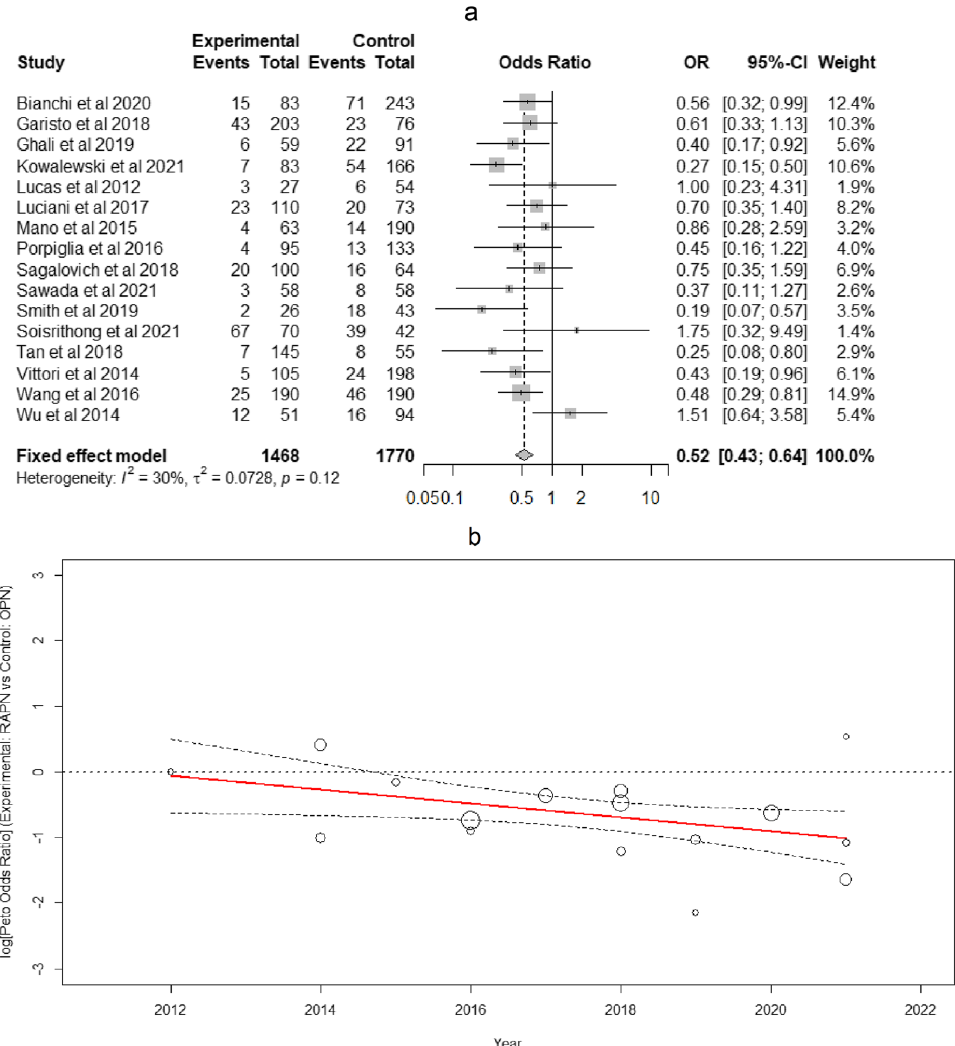
Fig. 3 a : Pooled analysis forest plot under the fixed effects model, showing a statistically significant reduction in the odds for mild complications in robotic compared to the open approach ( a statistically significant difference between the two approaches that is progressively expanding beyond 2014. According to this finding, patients undergoing robotic partial nephrectomy are less prone to the development of mild postoperative complications (CD: I and II) compared to those undergoing conventional open surgery, with the relative benefit becoming larger and larger over the years. Abbreviations: CD: Clavien–Dindo classification of postoperative